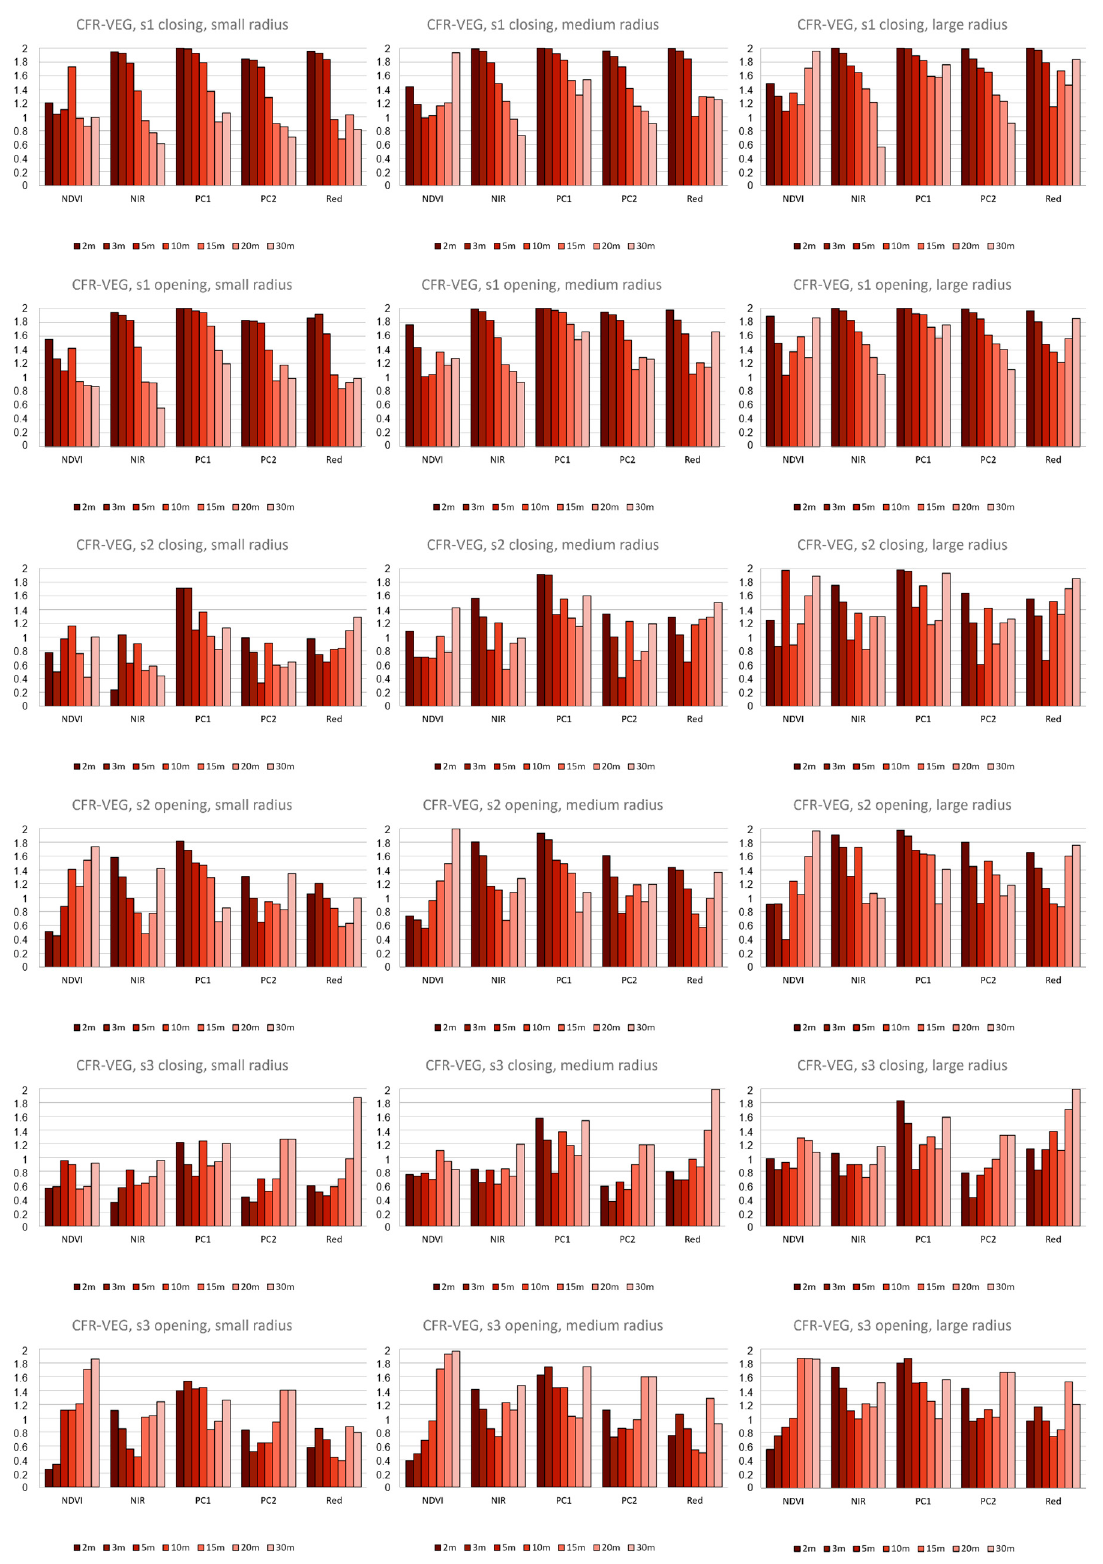
Figure 5. J–M distance diagrams for test fields for the coniferous forest/low vegetation class pair (CFR/VEG).